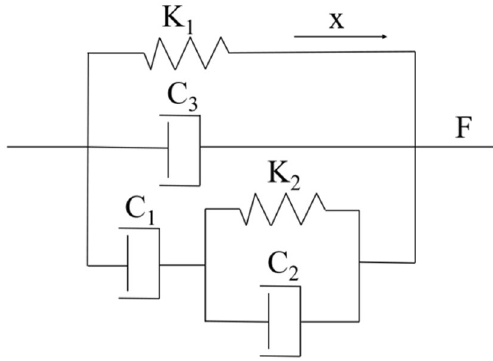
Figure 17. Five-parameter mathematical